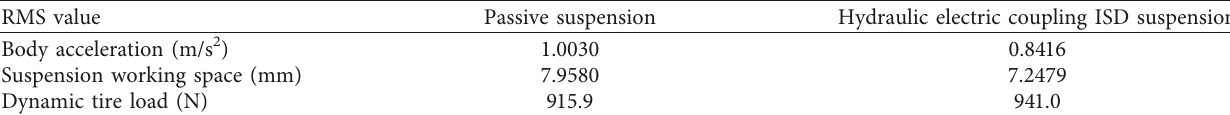
Table 8: Comparison of the RMS values of the test